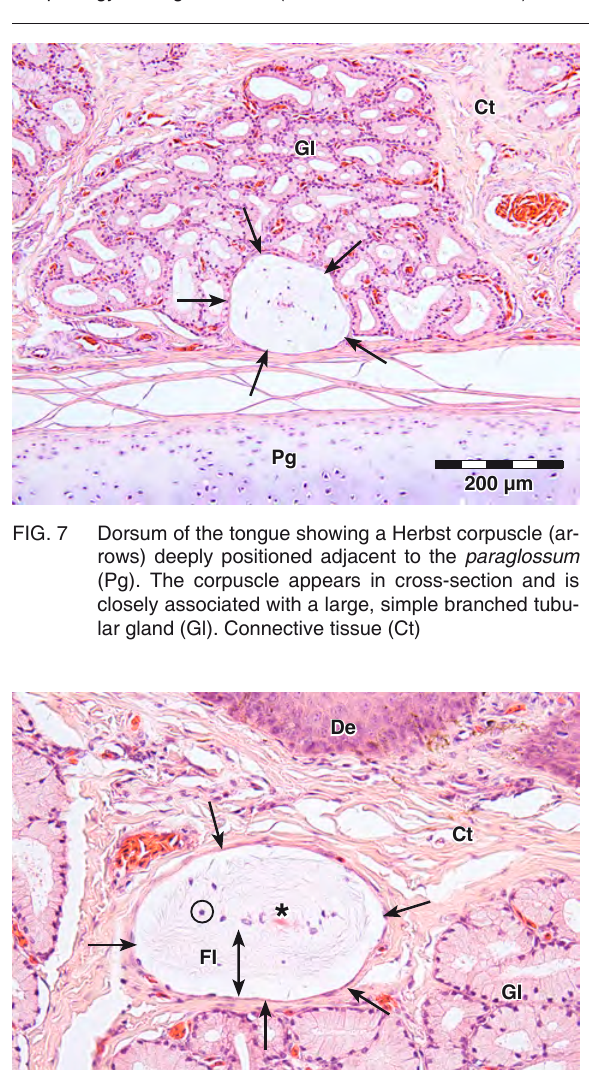
the topography of the lingual skeleton within the paren­ chyma. The paraglossum (Pg) lies dorsal to the rostral projection of the basihyale (Rb) which is flanked by adi­ pose tissue (Ad). Large, simple branched tubular glands (Lg), ventral epithelium (Ve), compressed submucosa (double­headed arrow). PAS stain